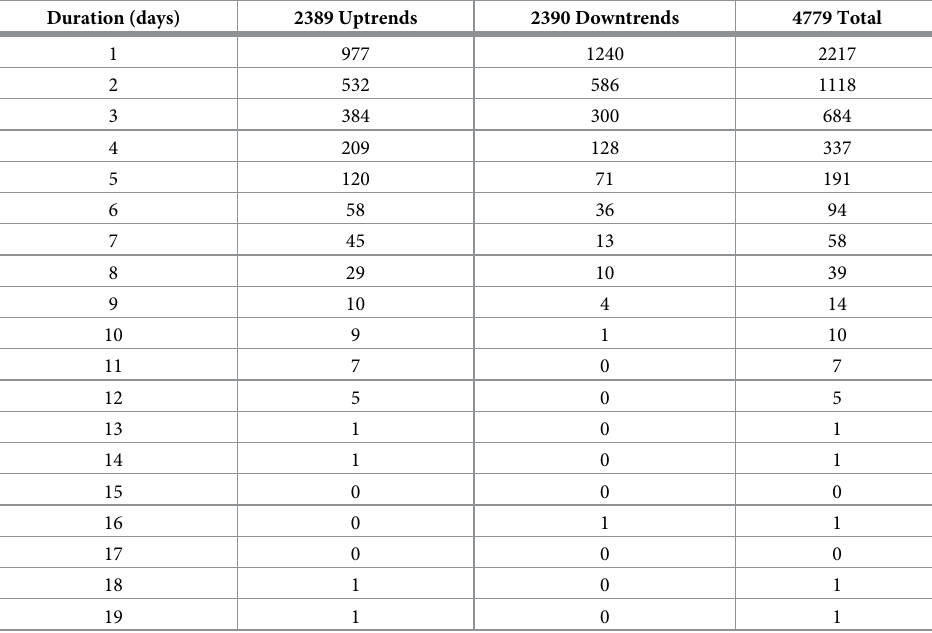
Table 3. Composition of uninterrupted trends observed in the Nasdaq data sample.